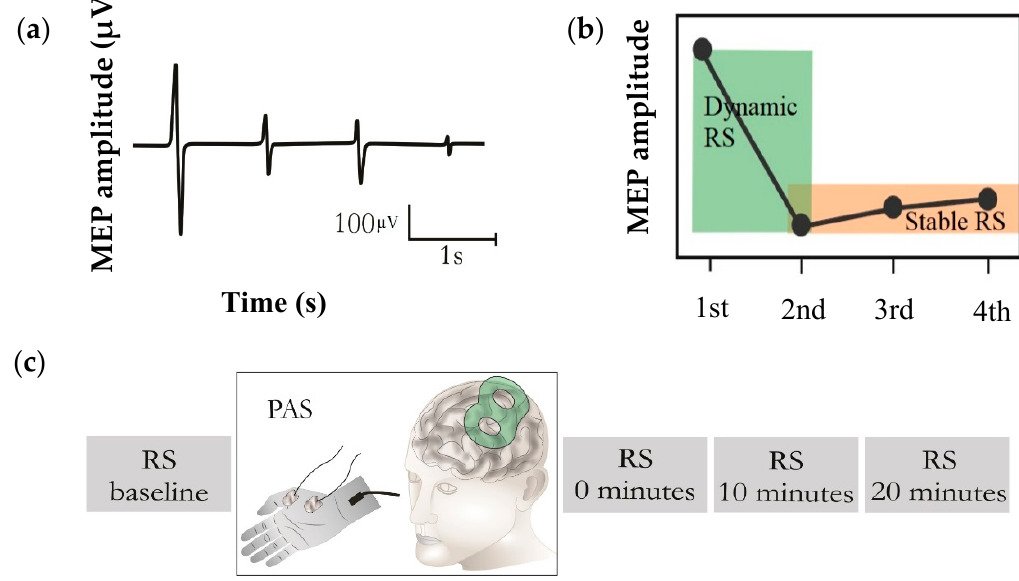
Figure 1. Repetition suppression (RS) paradigm. ( a ) Typical RS. Motor evoked potentials (MEPs) were recorded during four identical TMS pulses. ( b ) The RS paradigm was divided into two components for the analysis: “dynamic RS”, i.e., the ratio of the second MEP to the first one, and “stable RS”, i.e., the mean of the second, third, and fourth MEPs. ( c ) RS applied before (baseline) and after PAS intervention (at 0 min, 10 min, and 20 min). In the PAS intervention, electrical stimulation of the median nerve-innervated APB muscle was delivered prior to TMS at an ISI of 25 ms to generate plasticity.